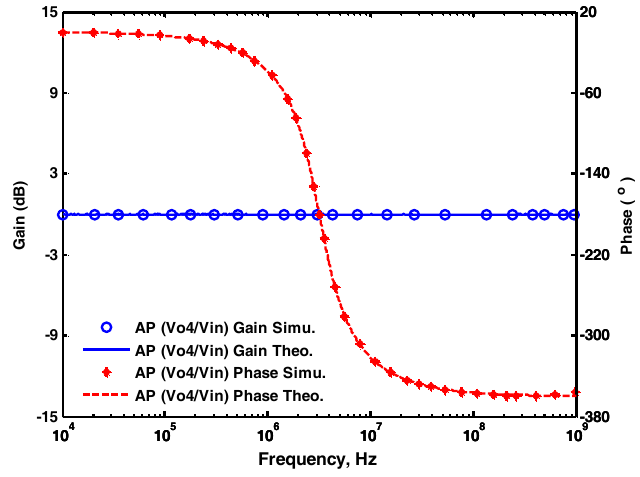
Figure 7. The VM-simulated allpass filter frequency responses of Figure 2.